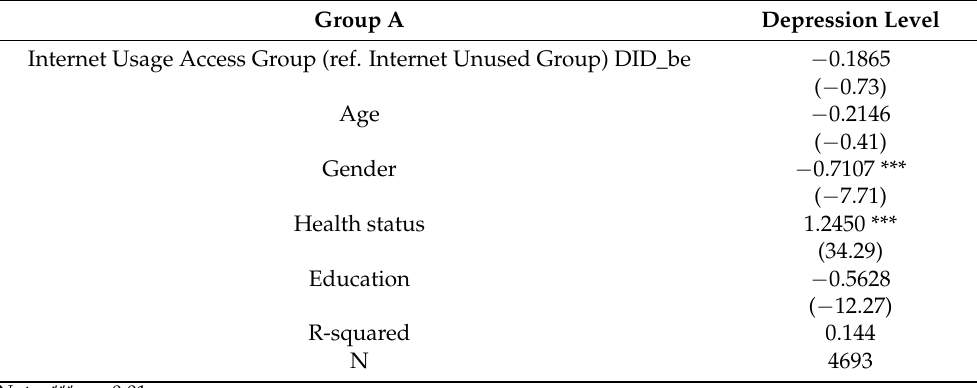
Table 6. Results of Placebo effect test. Group A Depression